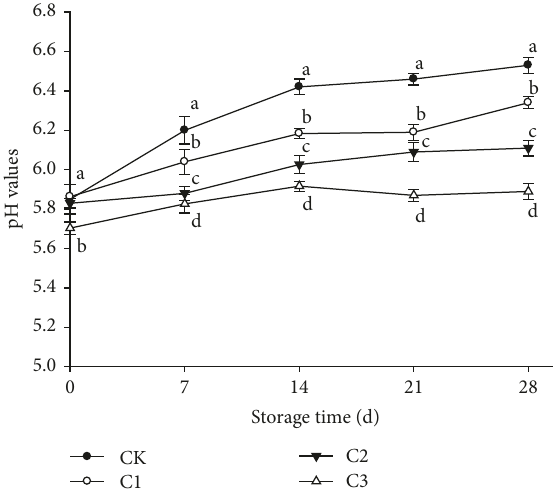
Figure 2: Changes in total bacterial counts of beefsteaks with different treatments during storage. CK, the group of beefsteaks without pretreatments; C1, the group of beefsteaks pretreated with 100% CO for 1.5 h; C2, group of beefsteaks pretreated with 100% CO for 1.5 h and soaked in 50mg/L ClO 2 ; C3, group of beefsteaks pretreated with 100% CO for 1.5 h and soaked in 50 mg/L ClO 2 for 10min and sprayed with 30g/L lactic acid. Data were represented with mean values ± Standard Error; sometimes the bars were too small to see. Different letters mean significant difference of samples with different treatments on the same storage days ( 𝑃 < 0.05 ). Three separate steaks of each treatment were measured; three repetitions were performed for each treatment. 𝑛 = 9 .